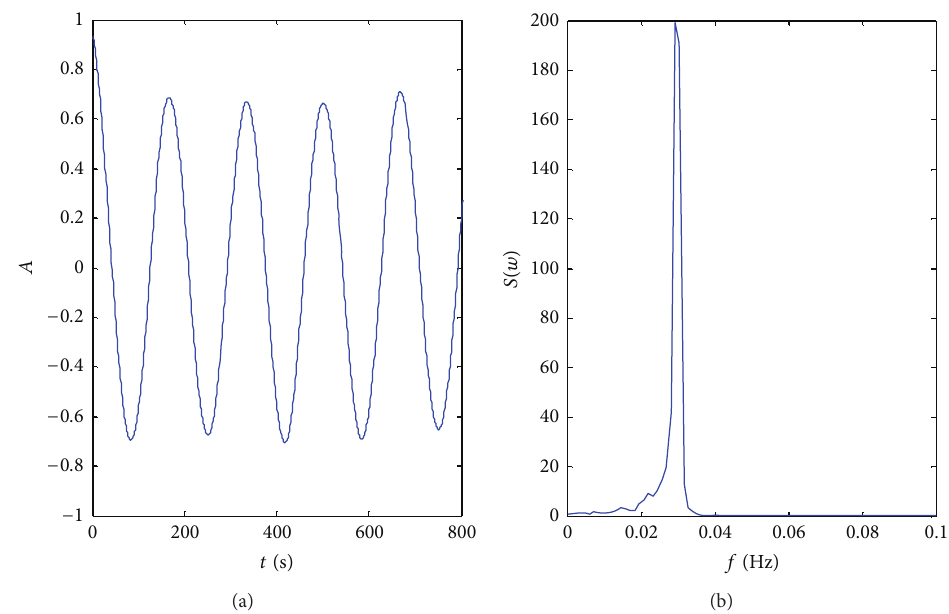
Figure 4: (a) The time-domain diagram of stochastic resonance output signal after correlation processing and (b) the spectrum diagram of stochastic resonance output signal after correlation